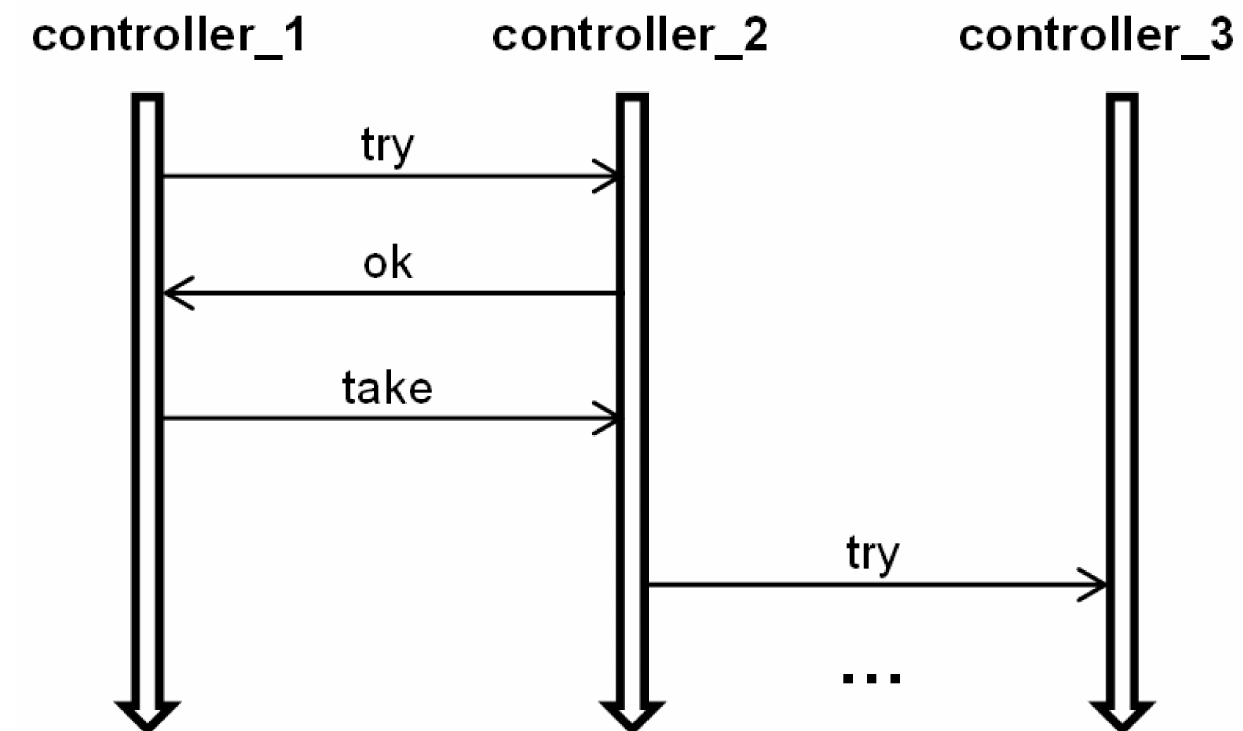
Figure 11. The protocol of road segment controller